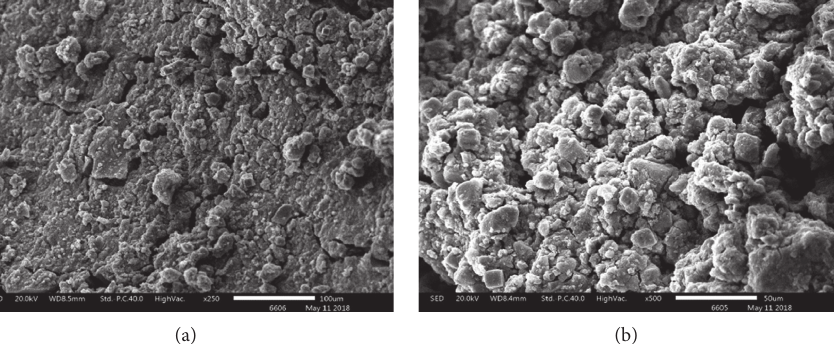
Figure 7: SEM photos without fibers: (a) specimen surface, 250x; (b) specimen surface, 500x.